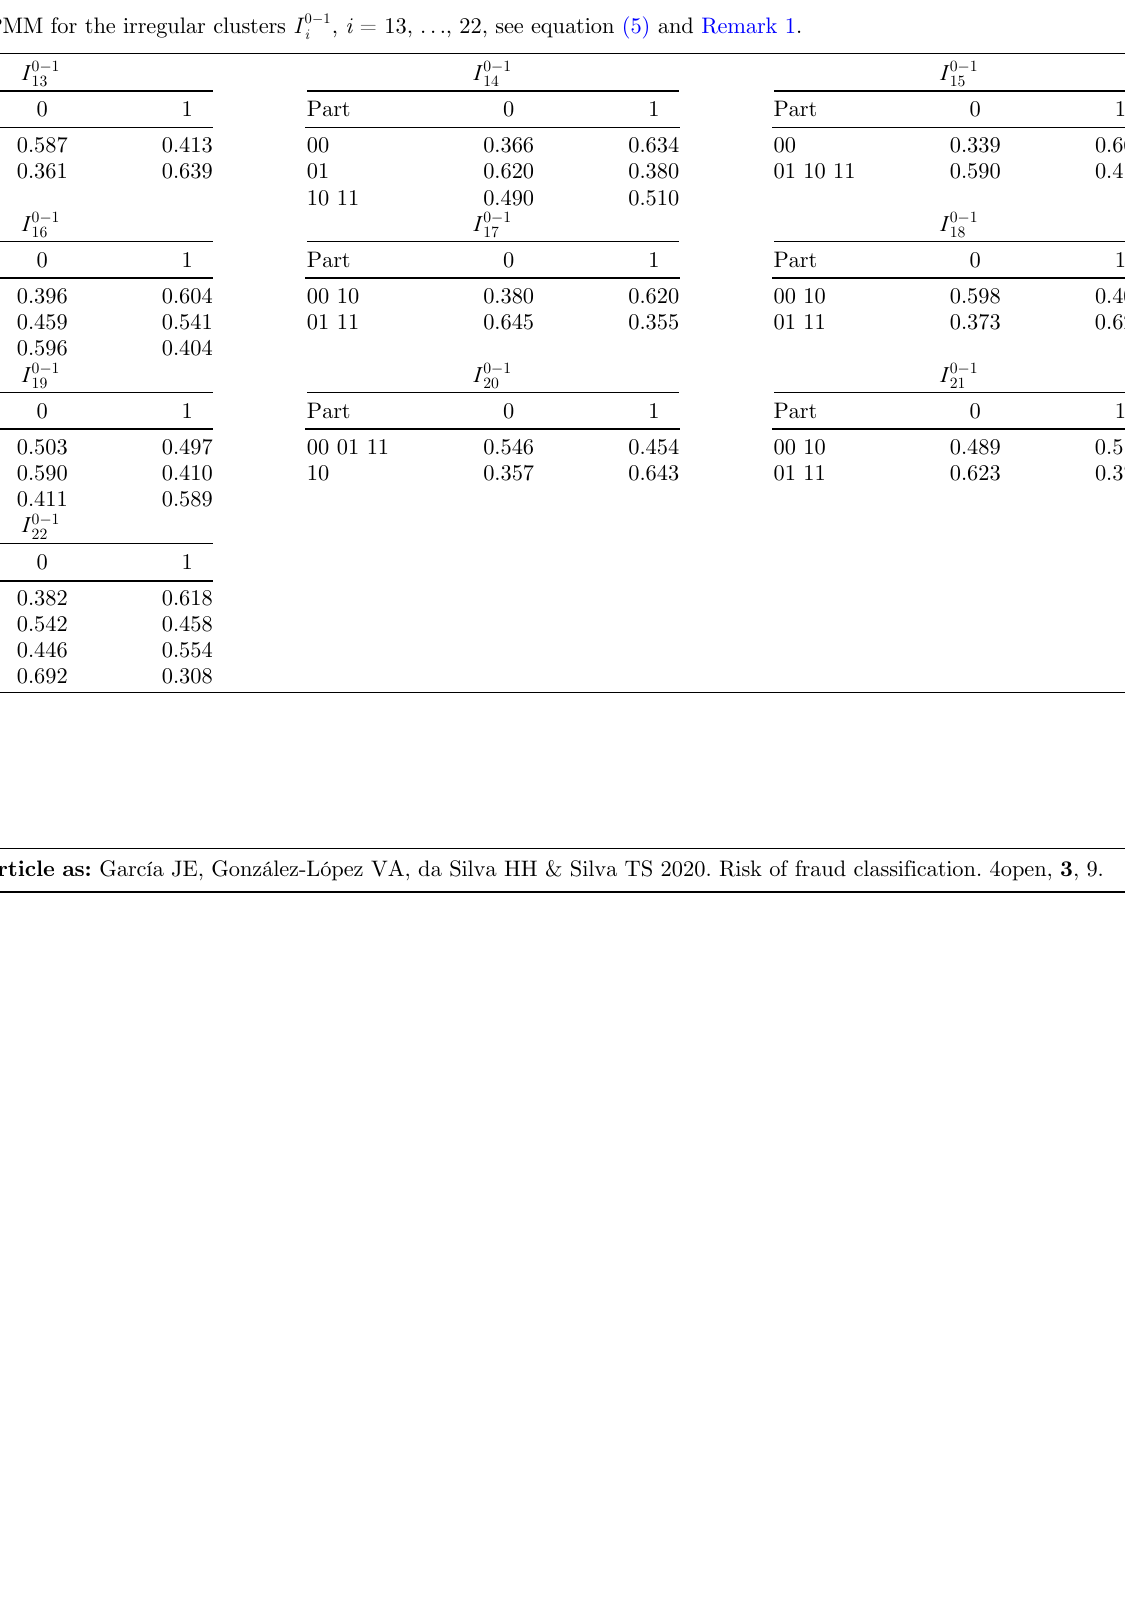
Table A2. PMM for the irregular clusters I 0 (cid:3) 1